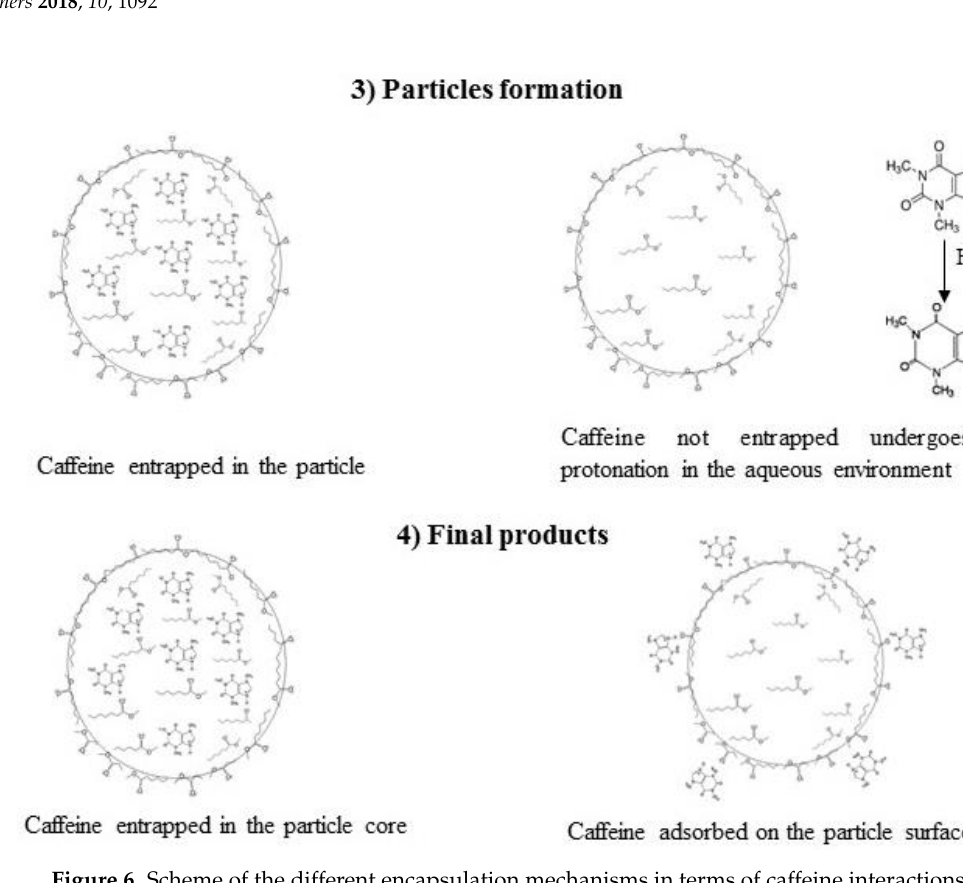
Figure 6. Scheme of the different encapsulation mechanisms in terms of caffeine interactions.